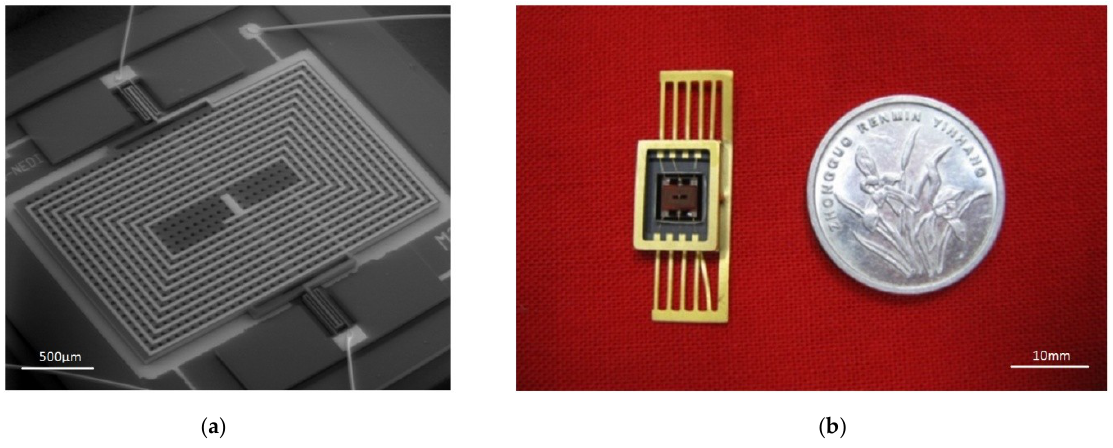
Figure 5. ( a ) MEMS structures for the torsional resonant magnetometer; ( b ) prototype of the MEMS torsional resonant magnetometer.